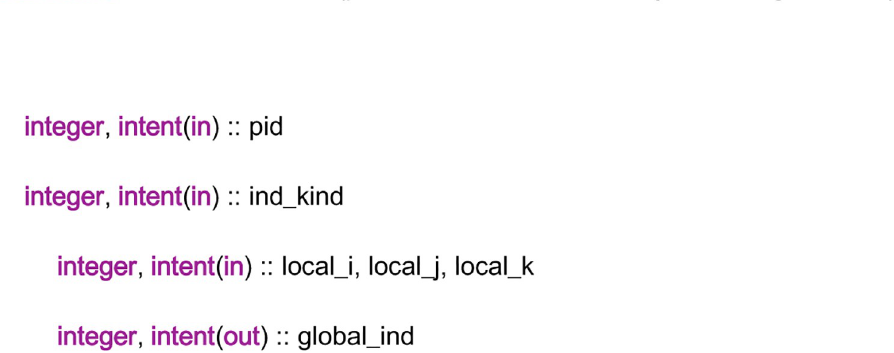
Fig 12. The head part of the code of the subroutine “coordiToGlobalInd”.